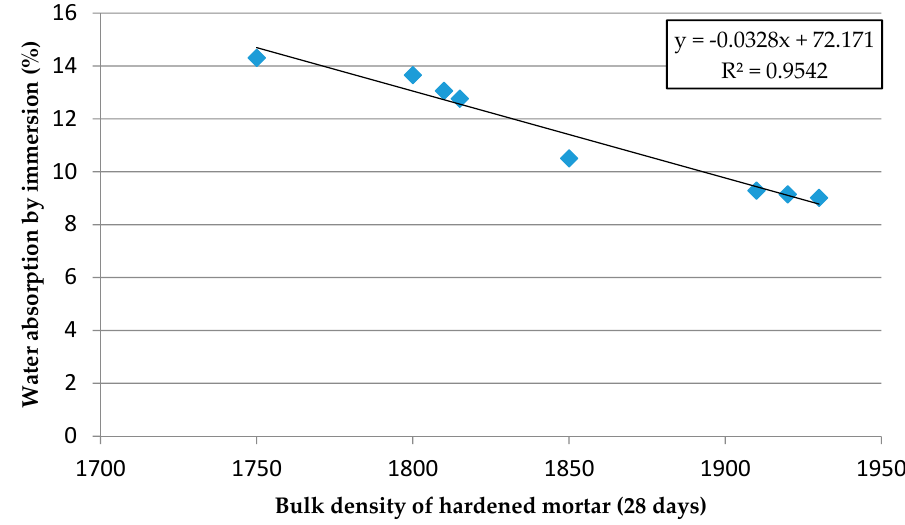
Figure 8. Water absorption by immersion vs. effective bulk density of hardened mortar.